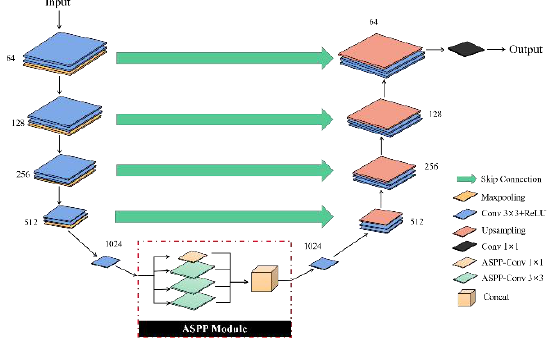
Fig. 1. Overview of the AU-Net network architecture